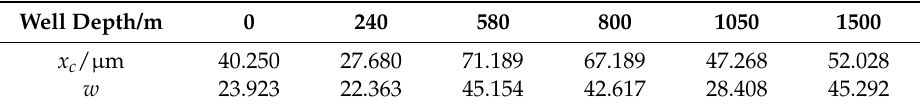
Table 5. Parameters for the Gaussian model fitting of corrosion depth